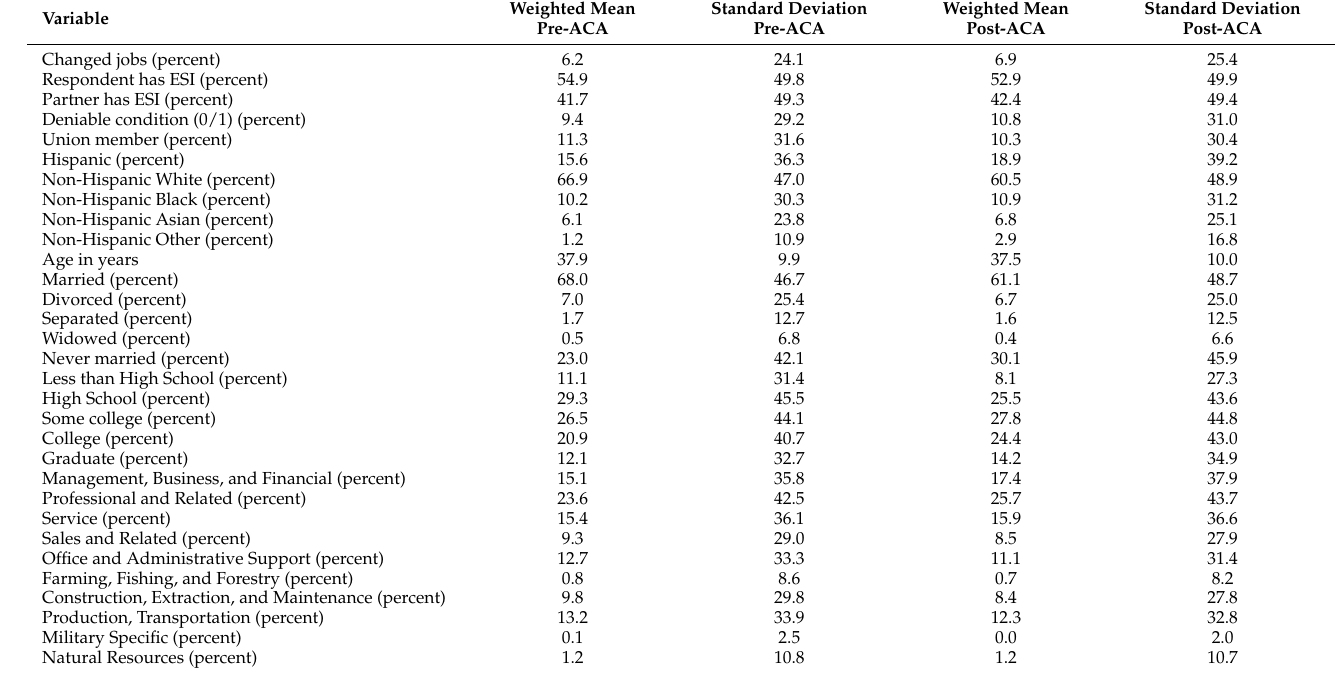
Table 1. Sample Means and Standard Deviations Medical Expenditure Panel Surveys (MEPS): 2001–2019. Variable Weighted Mean Pre-ACA Standard Deviation Pre-ACA Weighted Mean